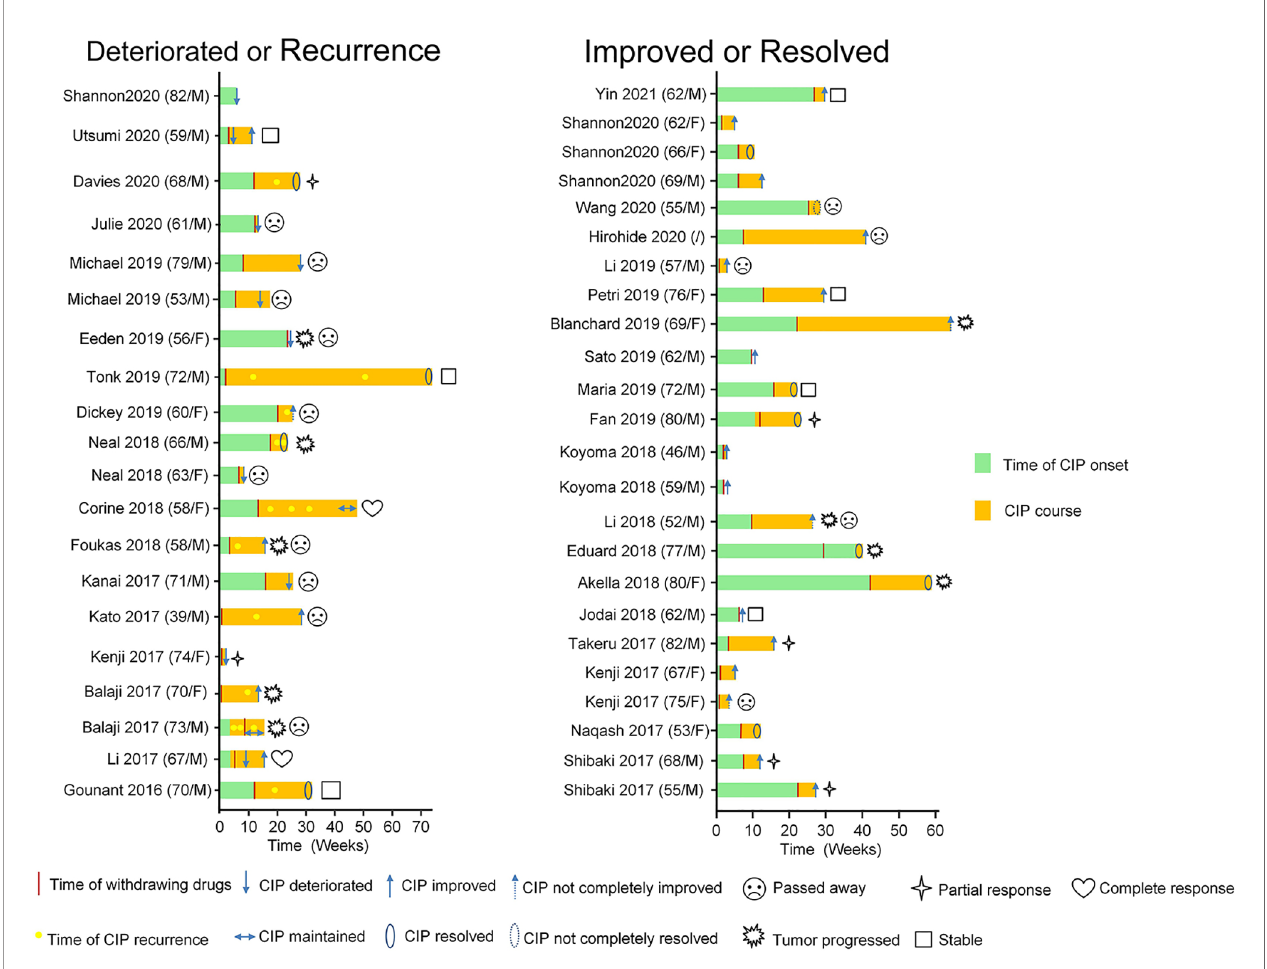
FIGURE 1 | Summary of checkpoint inhibitor pneumonitis patients with NSCLC, including deteriorated or recurrence (n = 20) and improved or resolved (n = 24) patients with more details in Table 1